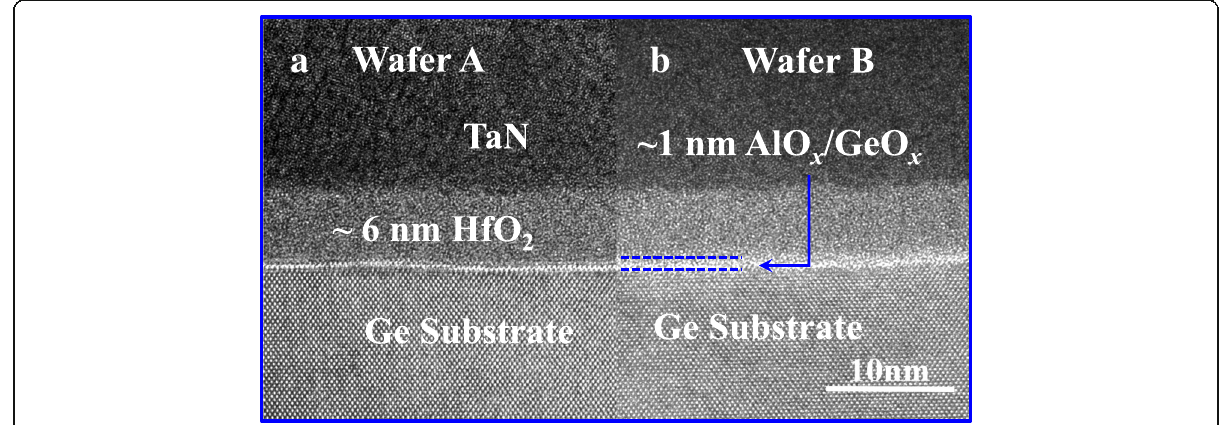
Fig. 2 Cross-sectional TEM images of the high-k/metal gate stack with a AlO x /GeO x interfacial layer (IL) fabricated by a OPO and b PPO on a n-Ge (001)